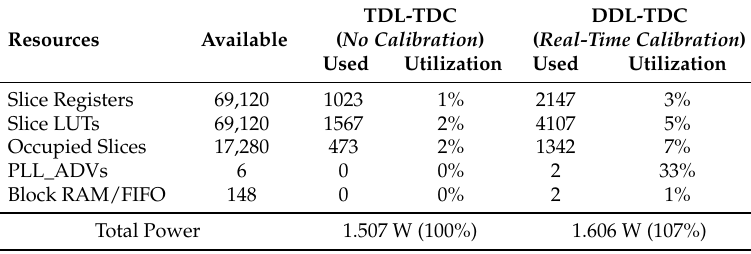
Figure 6. Experimental setup of the proposed DDL-TDC measured system. Table 2. FPGA resource utilization and power consumption of the